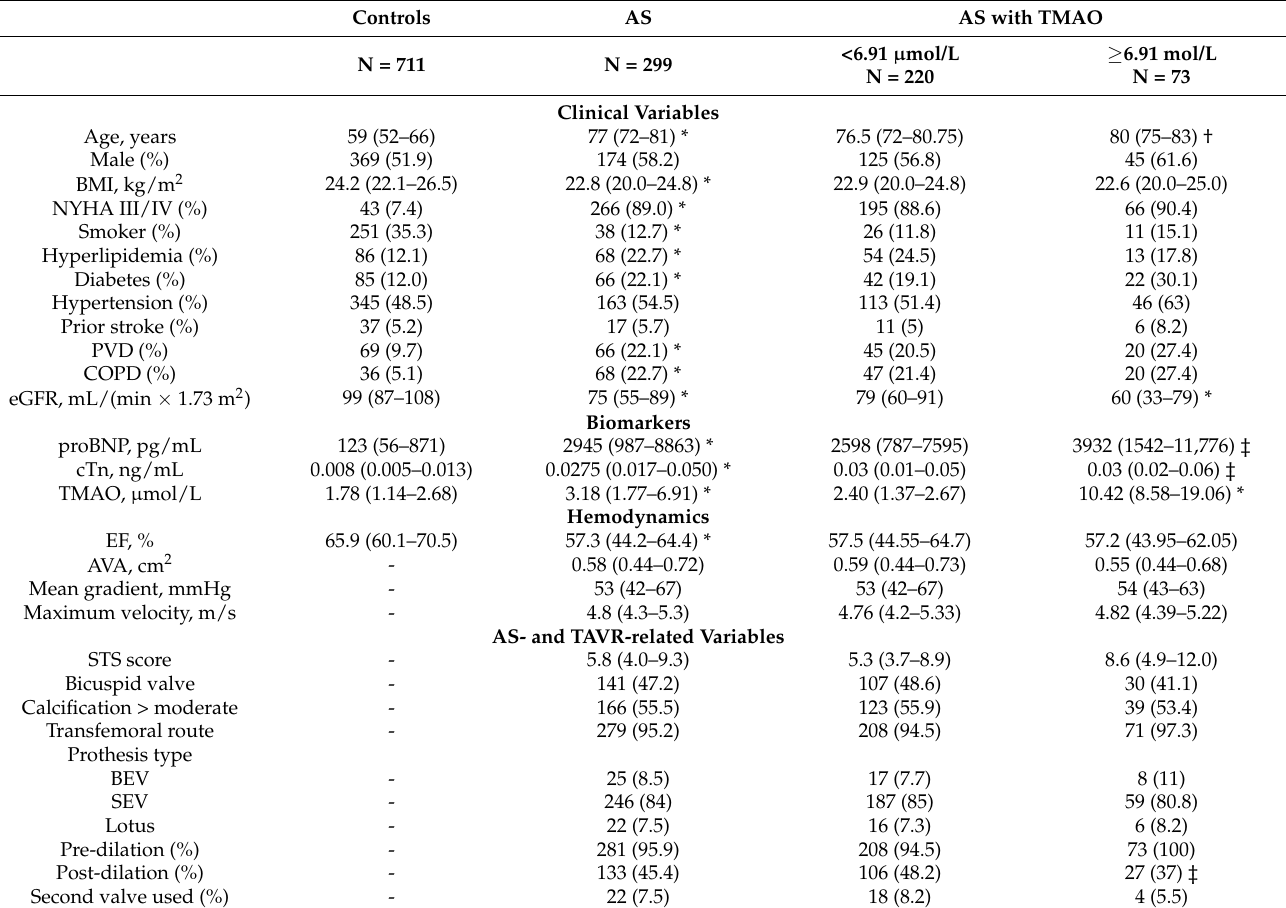
Table 1. Characteristics of aortic stenosis patients and